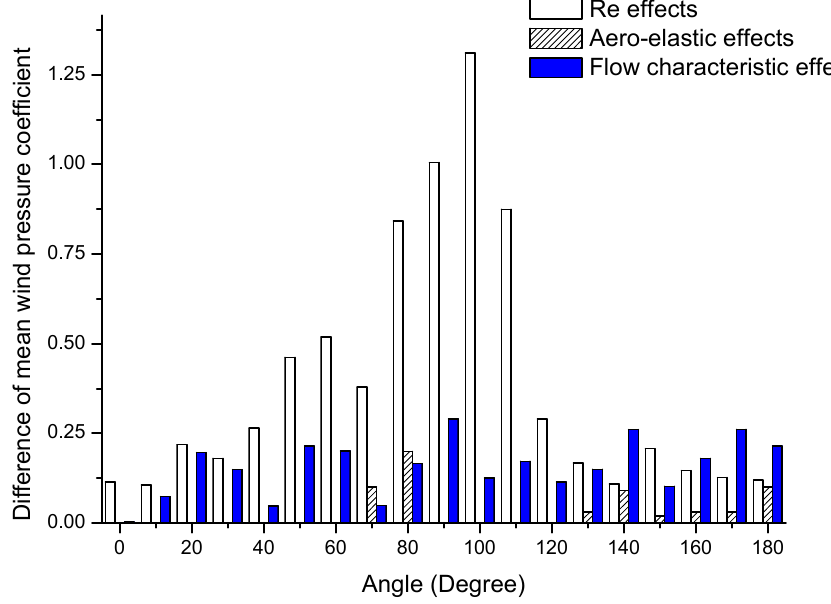
Figure 13. Comparison of the three adverse effects for mean wind pressure coefficients. Table 2. The three adverse effects in relative errors.